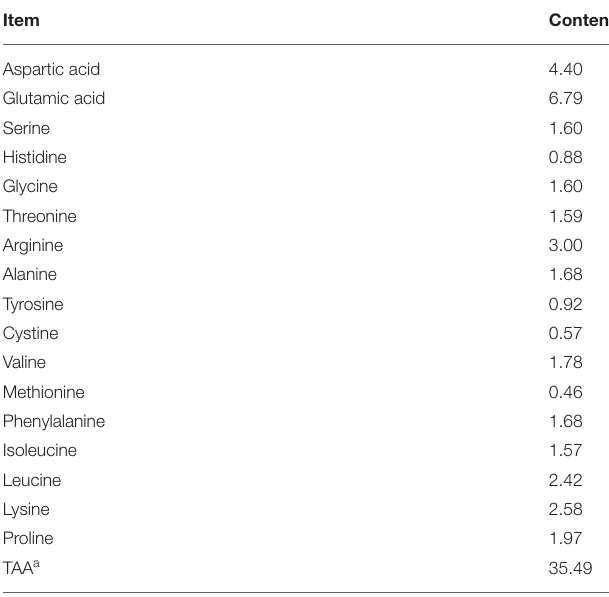
TABLE 1 | Ingredients and chemical composition of total mixed ration (dry matter basis, %).